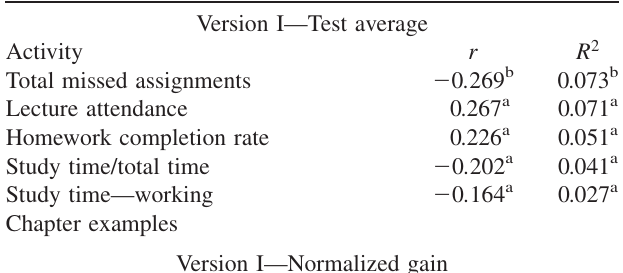
TABLE V. Five most highly correlated